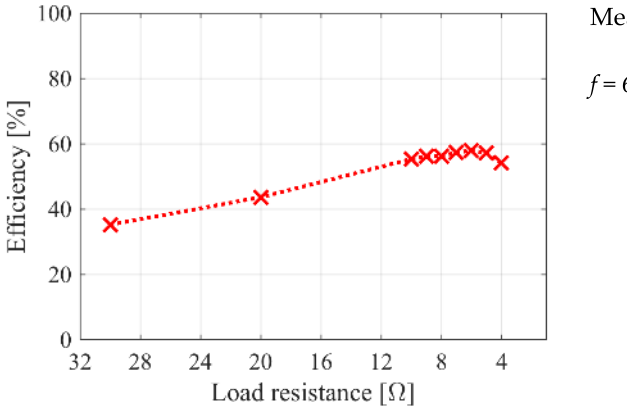
Figure 21. Efficiency dependence on load resistance.